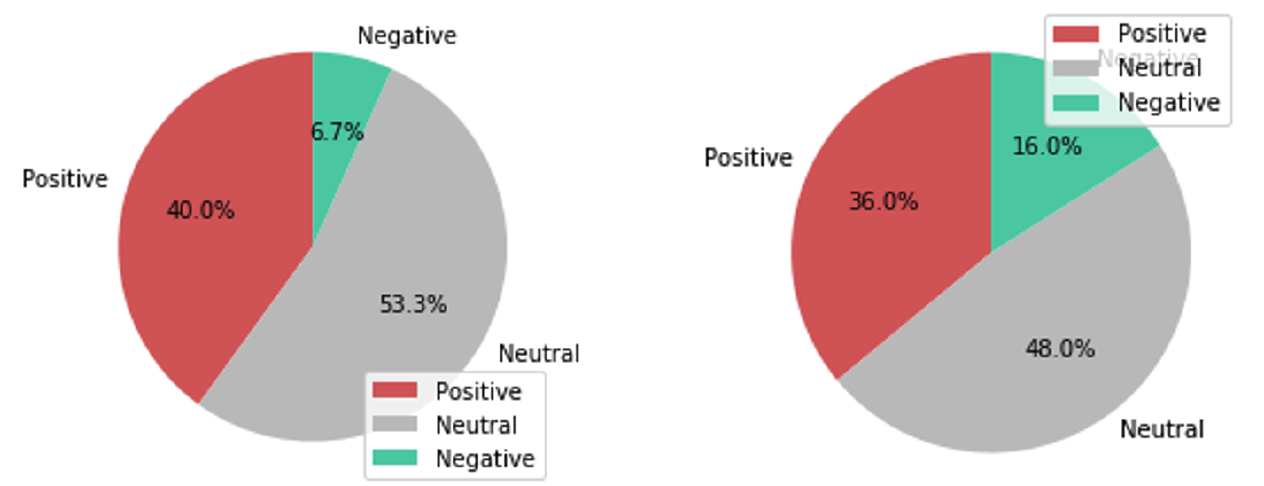
Figure 4. Sentiment analysis for StockTwits ( left piechart) and Twitter ( right piechart) datasets using